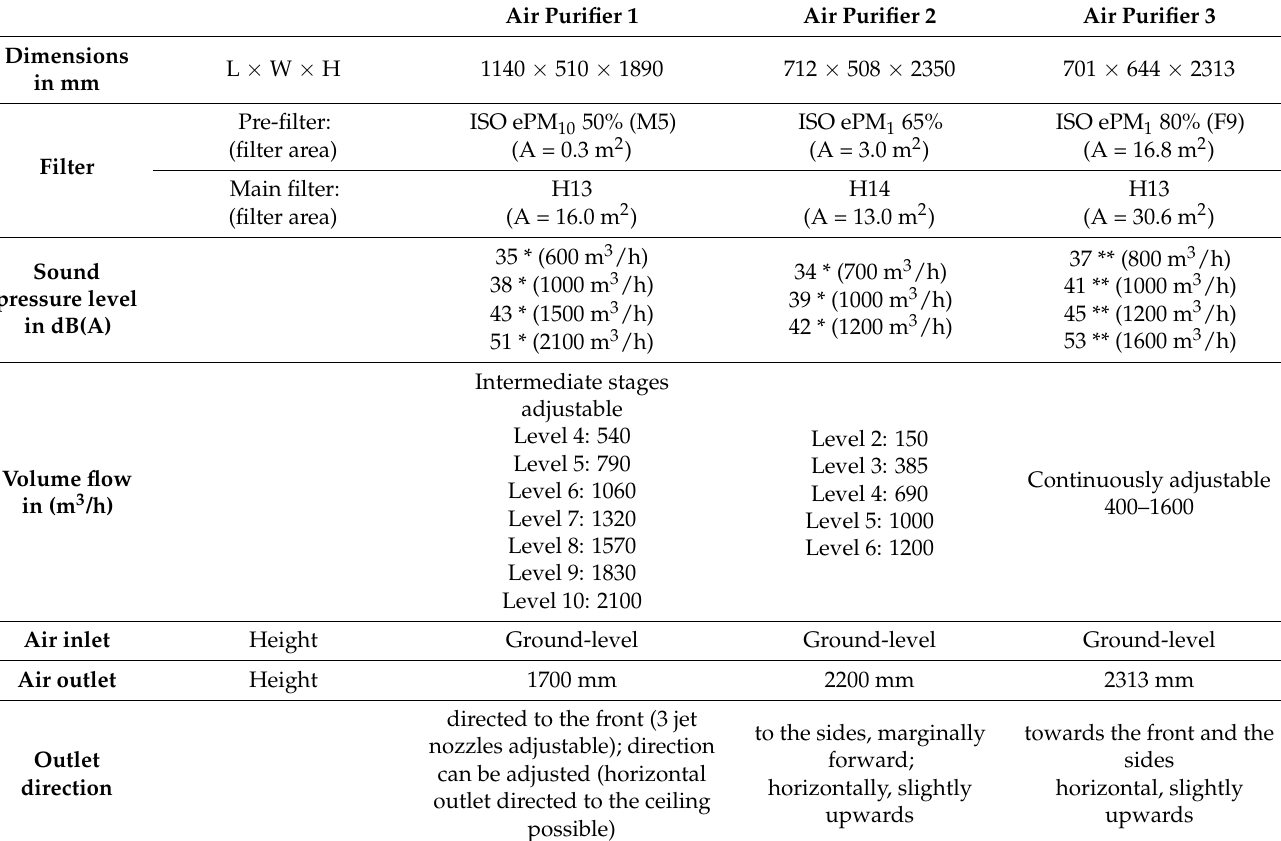
Table A1. Manufacturer’s data of the three devices used in this study.